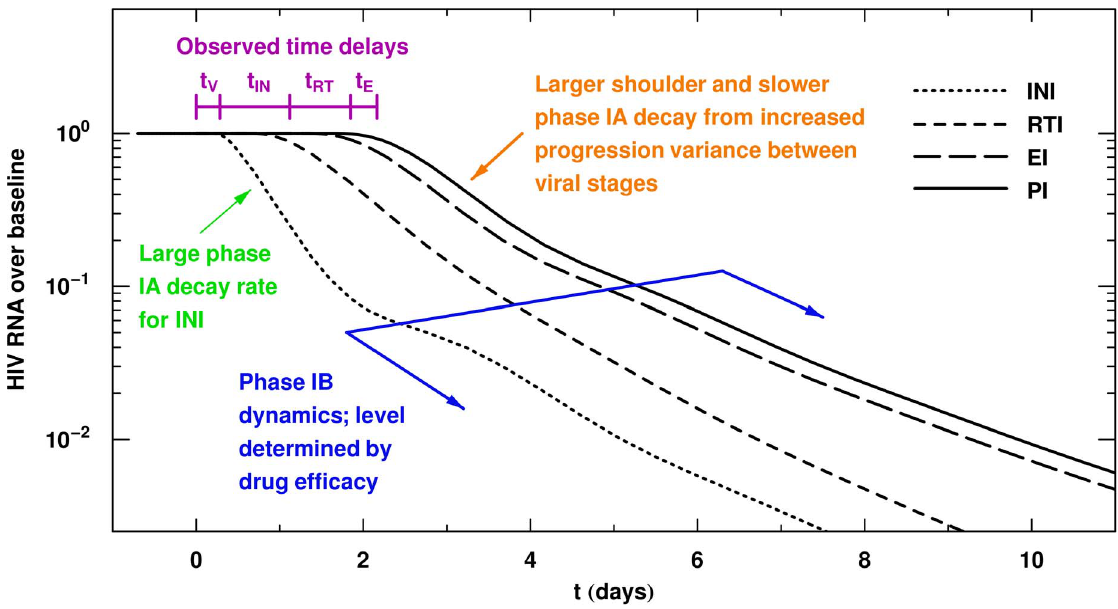
Figure 8. Plasma HIV RNA curves for the four drug classes INI, RTI, EI, and PI. The dotted, short dashed, long dashed, and solid lines are model simulations where the effects of an INI, RTI, EI, and PI respectively were modeled. The key features of the model have been labeled. The time delays are given by t i ^ D t i z log(2) = l i . An efficacy of 0.95 has been used for each drug.